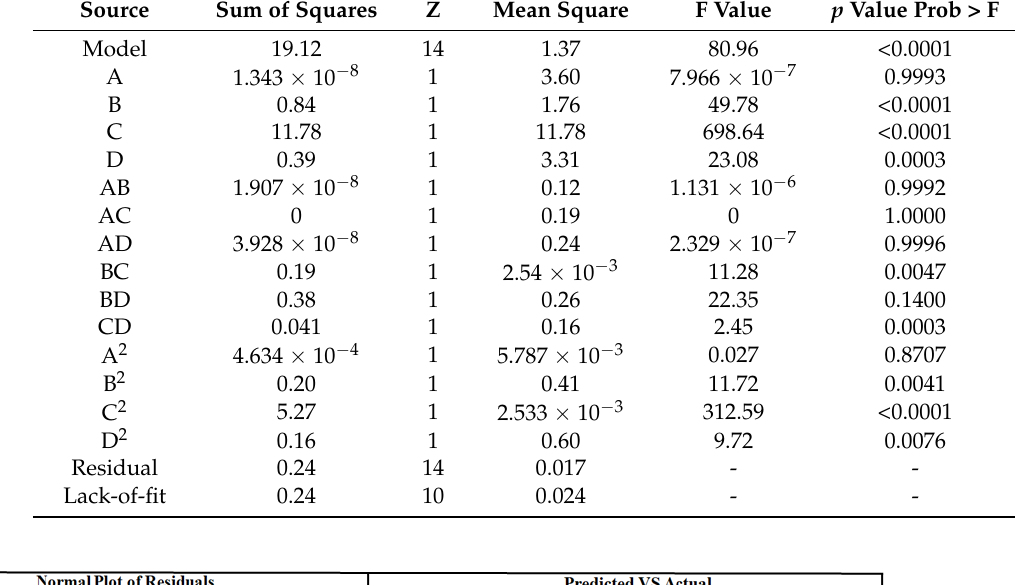
Table 2. ANOVA results.